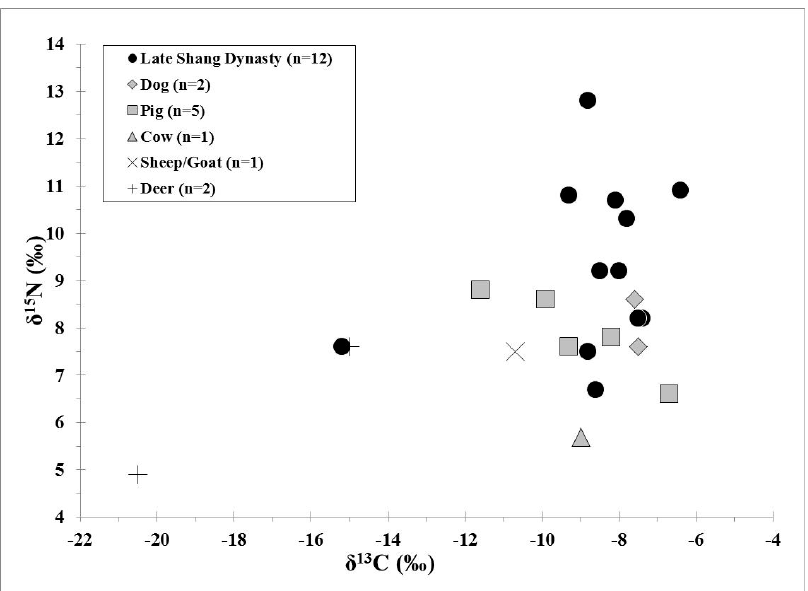
Figure 3. δ 13 C and δ 15 N results for humans from the Xiaohucun site and animals from the Guandimiao site Henan Province, China.